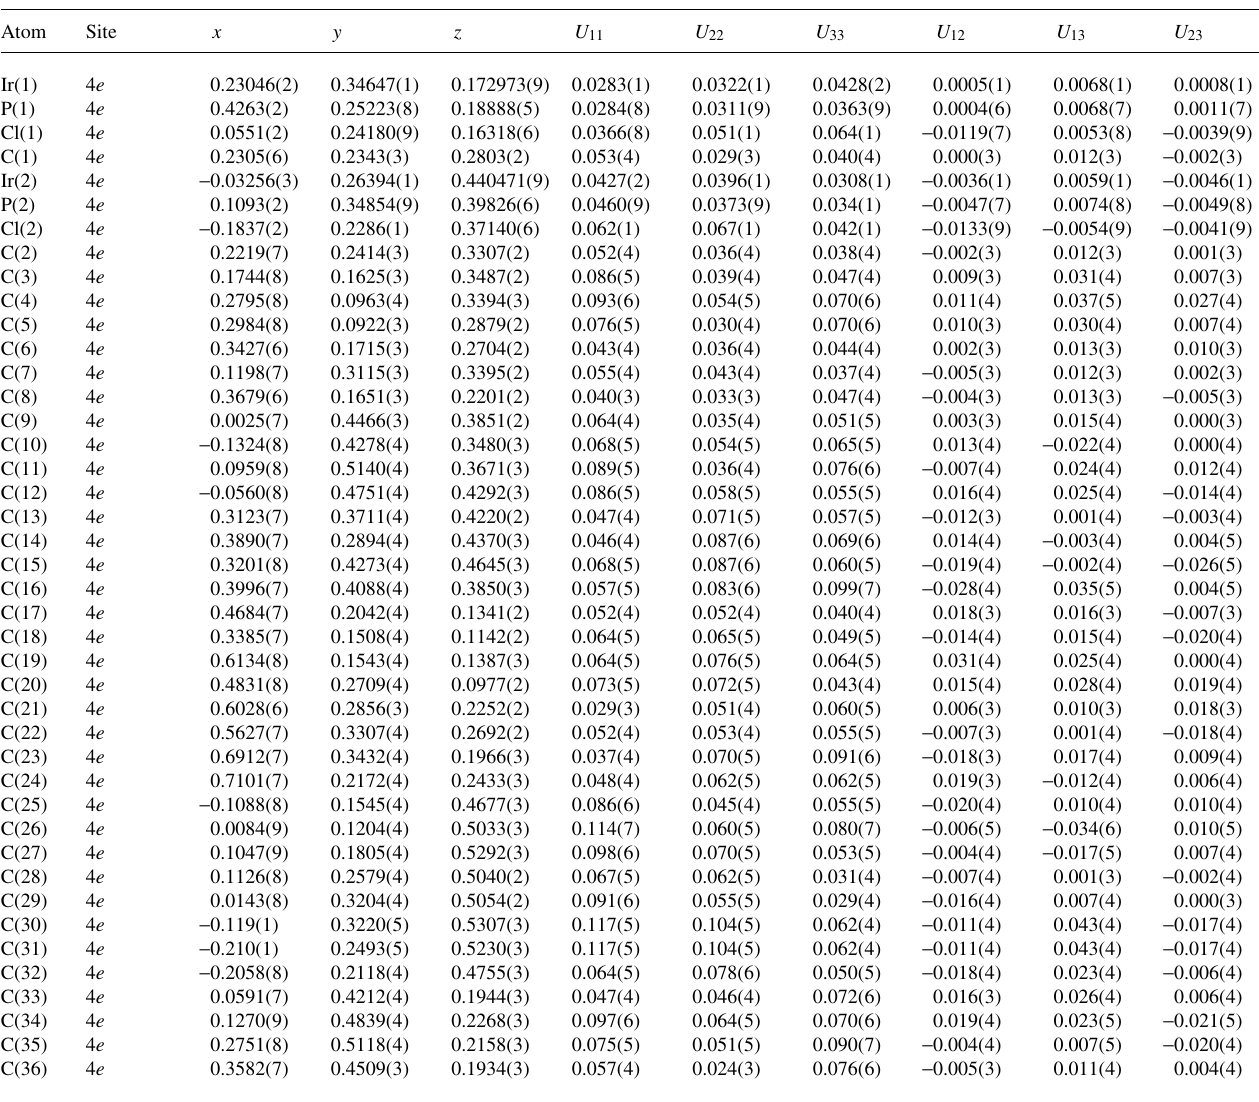
Table 3. Atomic coordinates and displacement parameters (in Å 2 )